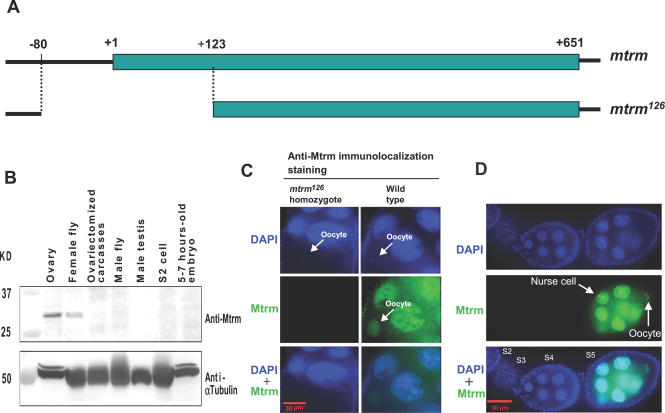
The mtrm Gene and Its Expression Pattern(A) Schematic diagram of the 651-bp mtrm gene. The mtrm126 deletion allele, which was created by imprecise excision of the P element insertion mutation KG08051, is deleted for 203 bases (80 bases upstream of the first ATG in mtrm and 123 downstream of that ATG).(B) Mtrm is expressed exclusively in ovaries. Protein extracts from the indicated tissues were analyzed by Western blotting using an antibody to Mtrm. These experiments reveal that Mtrm, a 27-kDa protein, is expressed only in ovaries. The lower panel displays a Western blot of equal amounts of protein from the same extracts probed with antibody to alpha-tubulin (50-kDa).(C) Immunostaining using the antibody to Mtrm to stage 9 oocytes reveals that Mtrm is expressed in the nuclei of both oocytes and nurse cells in wild-type egg chambers but not in mtrm homozygote egg chambers. The latter finding indicates the antibody to Mtrm is indeed specific to Mtrm.(D) Timing of Mtrm expression during oocyte development. Endogenous Mtrm expression is not detectable before stage 5. At stage 5, Mtrm localizes to both the oocyte and nurse cells. Scale, 30 μm.